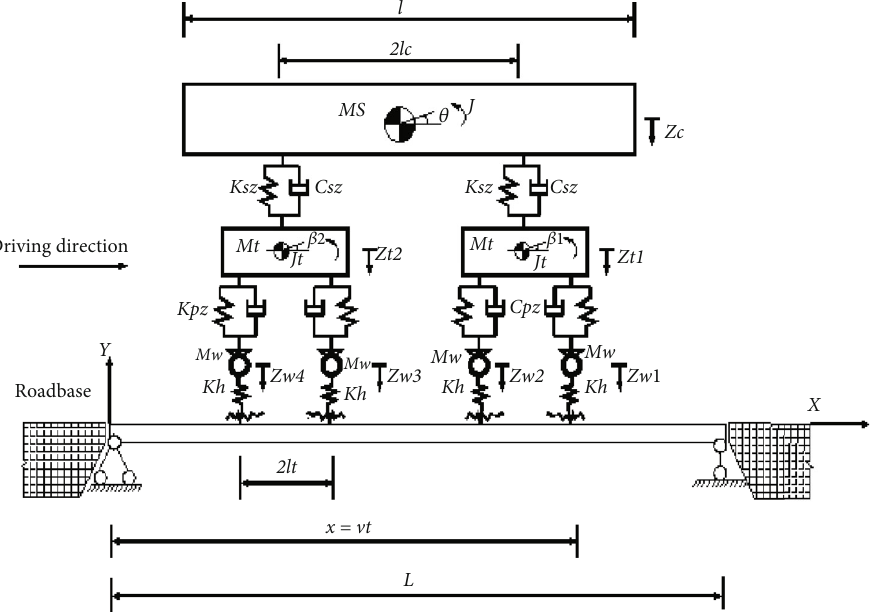
Figure 1: Vehicle model with 10 degrees of freedom. Table 1: Peak value of dynamic response of di ff erent nodes under di ff erent working